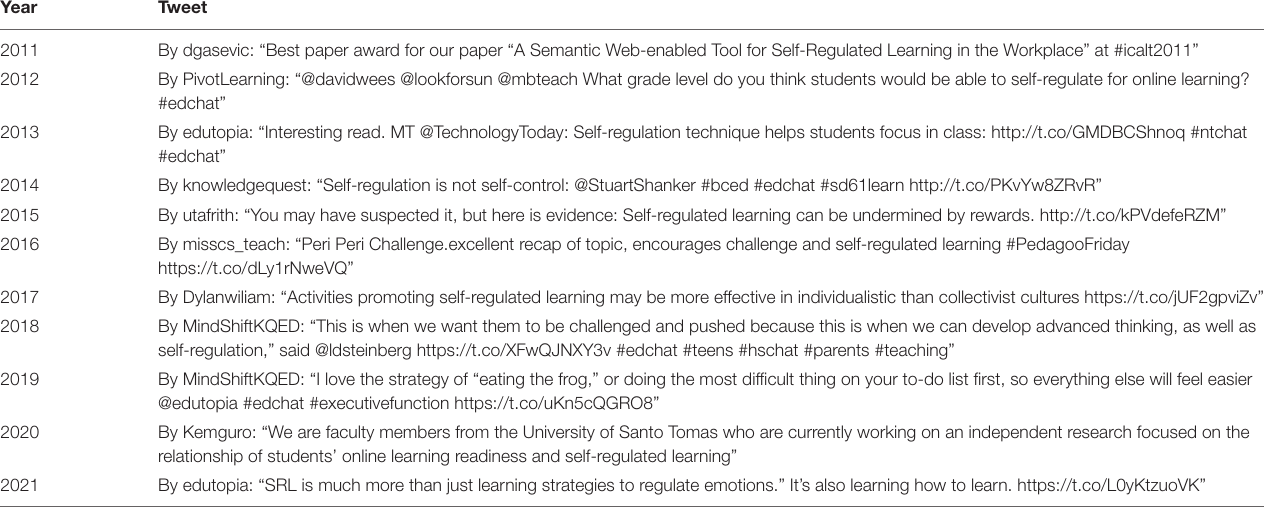
TABLE 4 | Selected high rating (i.e., in terms of like, retweet, and quote counts) tweets from the